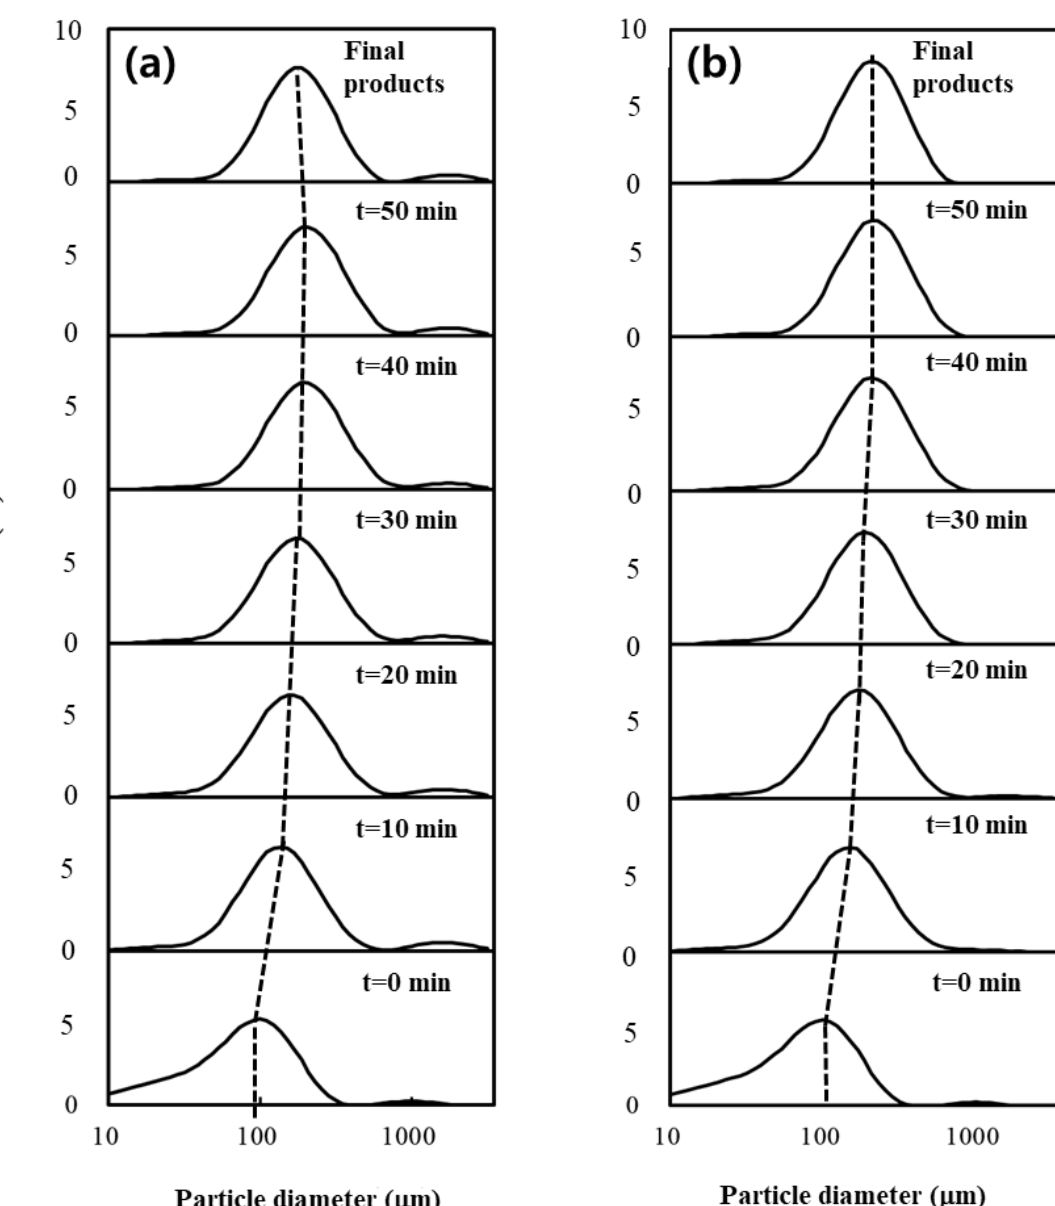
Figure 1. Evolution of PSD of samples taken at different agglomeration times during agglomeration with ( a ) water and ( b ) MD binders.